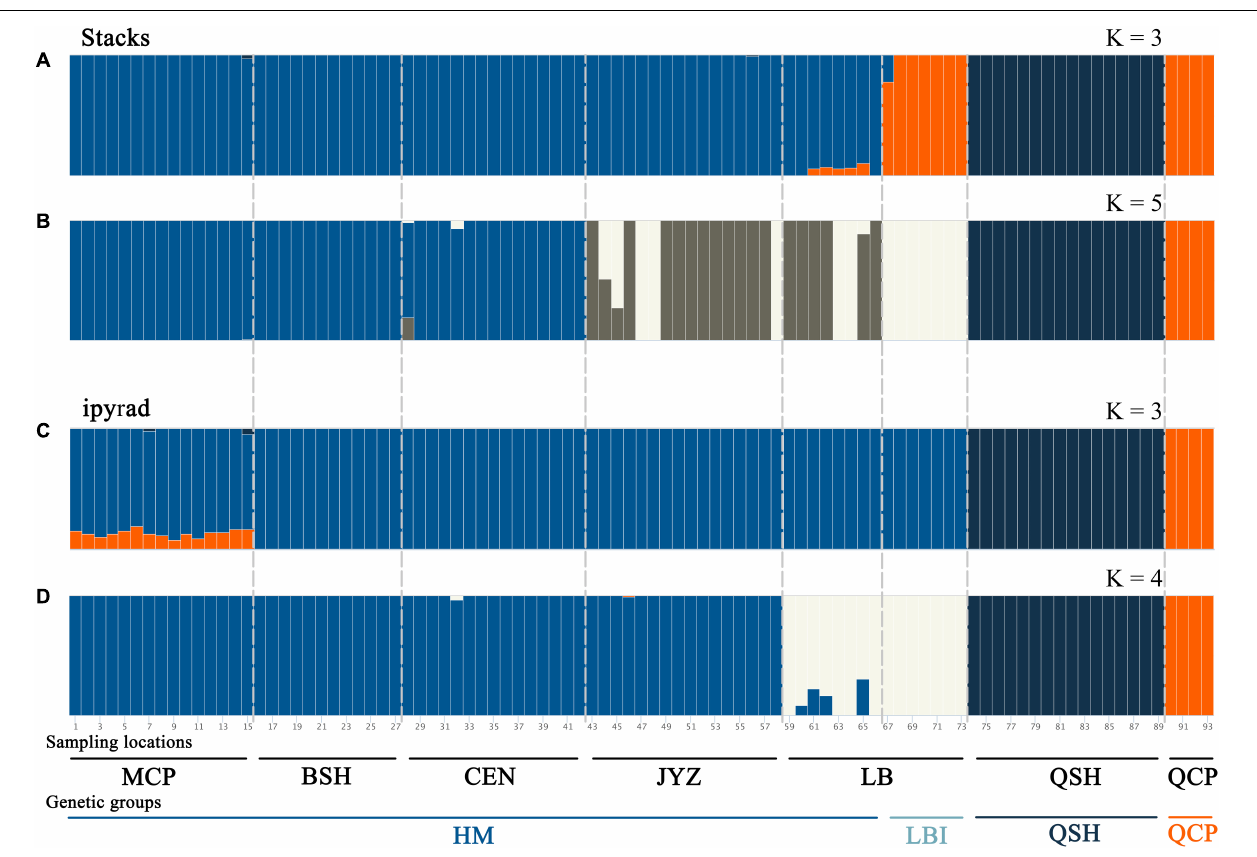
FIGURE 3 | Population structure of Magnolia fistulosa inferred by two data sets. Admixture results with (A) K = 3 and (B) K = 5 in the Stacks data set, (C) K = 3 and (D) K = 4 in the ipyrad data set. The two lines represent each sampling location and the genetic cluster divided by DAPC and PCA analyses.